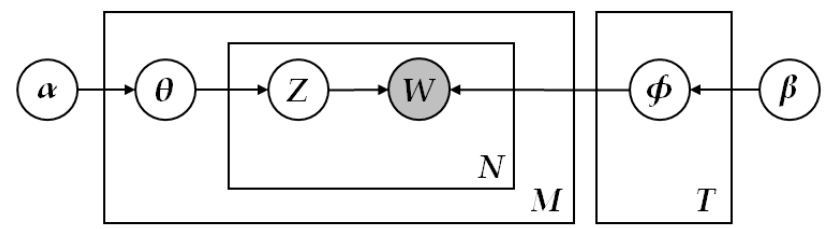
Figure 6. Graphical model representation of the latent Dirichlet allocation (LDA) generating mechanism.